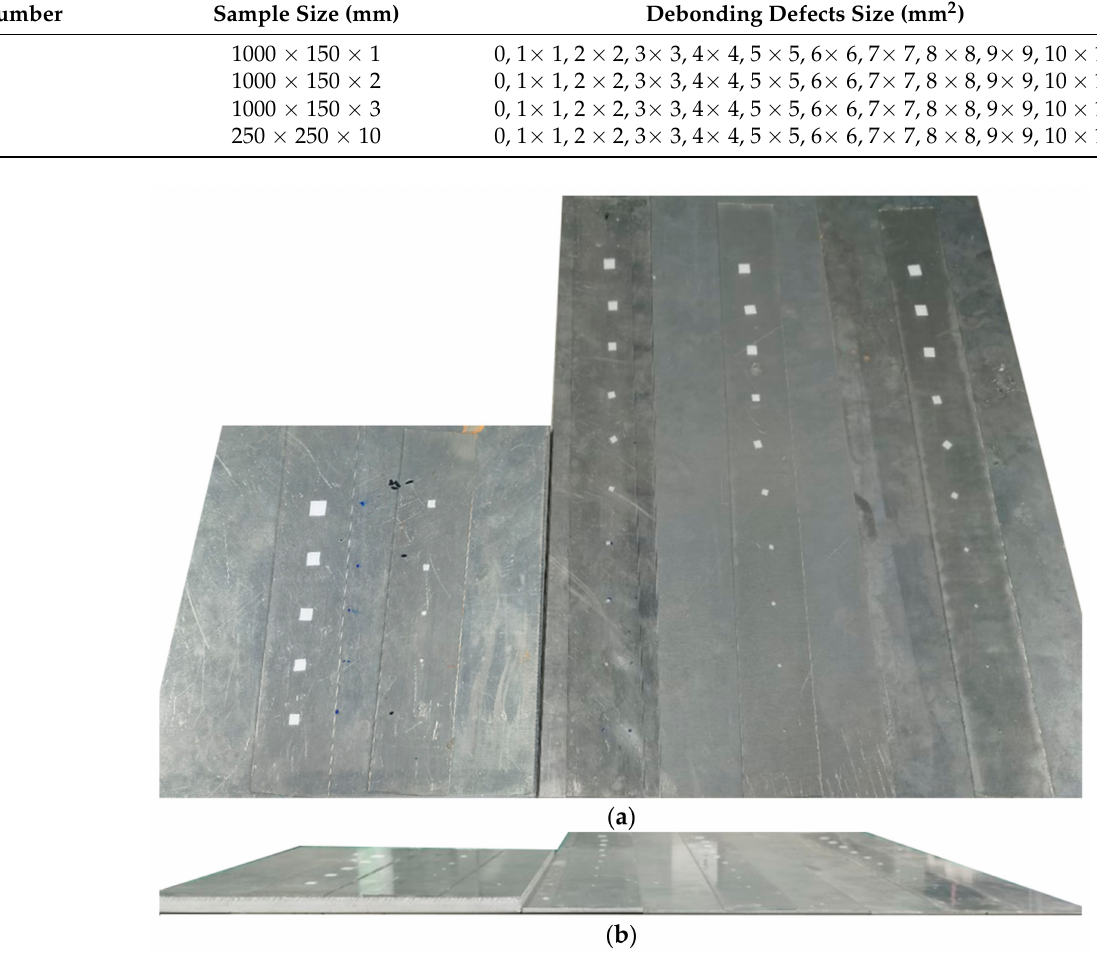
Figure 3. Sample physical drawing ( a ) Top view; ( b ) Side